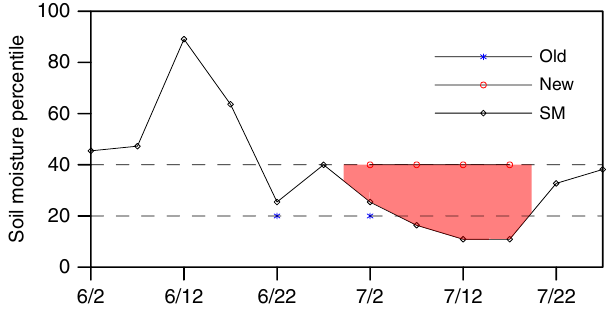
Fig. 1 Illustration of the de fi nition of a fl ash drought event. The black solid line shows 5 days mean soil moisture percentile (SM) for a grid point (112.75°E, 25.25°N) during the 2013 southern China fl ash drought. The dates in the horizontal axis are in the middle of the 5 days periods. The blue asterisks and red circles show fl ash droughts identi fi ed by concurrent heat and drought conditions (old; i.e., pentad mean surface air temperature anomaly larger than its standard deviation, and soil moisture percentile lower than 30%) and by the new de fi nition used in this study (new; the pentad mean soil moisture decreases from above 40th percentile to 20th percentile, with an average decline rate of no less than 5% in percentile for each pentad; if the declined soil moisture rises up to 20th percentile again, the drought terminates; and the drought should last for at least three pentads),